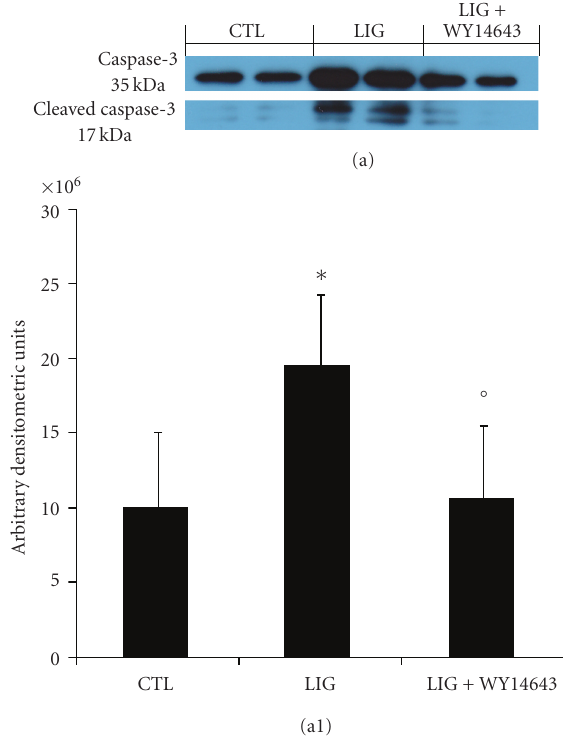
Figure 8: E ff ects of WY14643 on Cleaved caspase 3 levels. We have evaluated, by western blot analysis, a key mediator of apoptosis belong to the asparate-specific cysteinyl proteases or caspases. No cleaved caspase 3 expression were detectable in the homogenized gingivomucosal tissues from the contra lateral side obtained from vehicle-treated rats (a, a1).Cleaved caspase 3 levels were appreciably increased following ligation (a, a1). Treatment of rats with WY14643 (1mg/kg) significantly attenuated ligation-induced of Cleaved caspase 3 levels (a, a1). A representative blot of lysates (a, a1) obtained from 5 animals per group is shown and densitometry analysis of all animals is reported. Figure is representative of at least 3 experiments performed on di ff erent experimental days. ∗ P < . 01 versus nonligated. ◦ P < . 01 versus